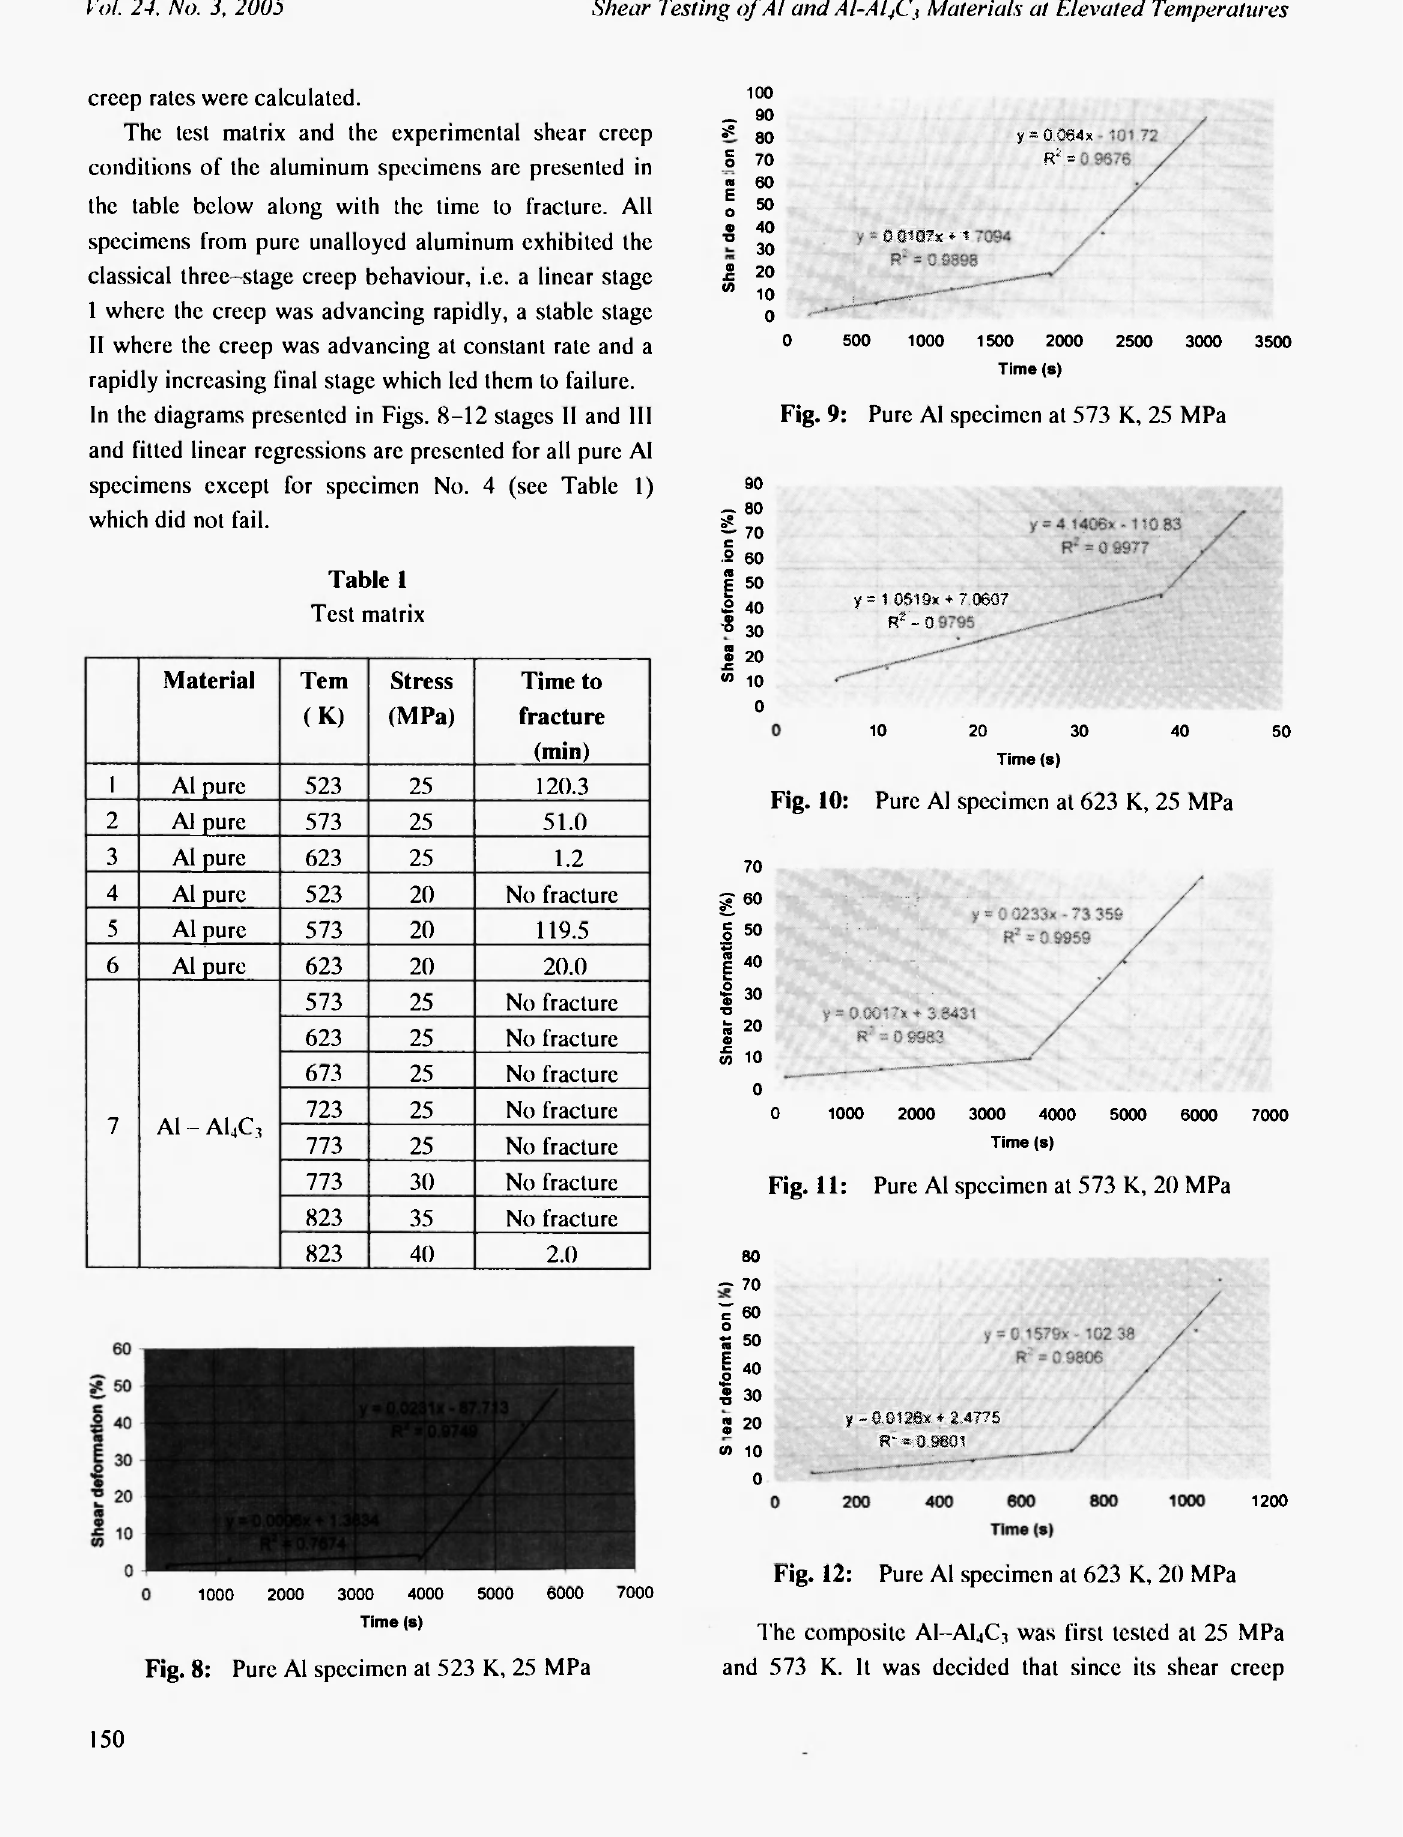
Fig. 12: Pure Al specimen at 623 K, 20 MPa The composite AI-AI4C3 was first tested at 25 MPa and 573 K. It was decided that since its shear